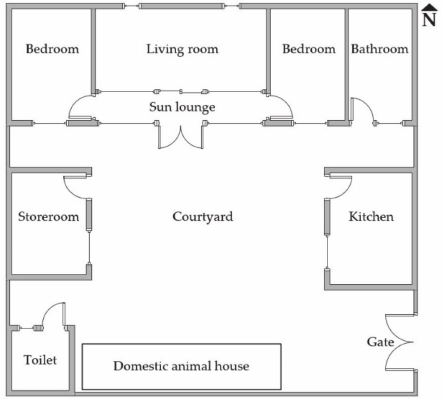
Figure 1. Typical floor plan of a rural residence in